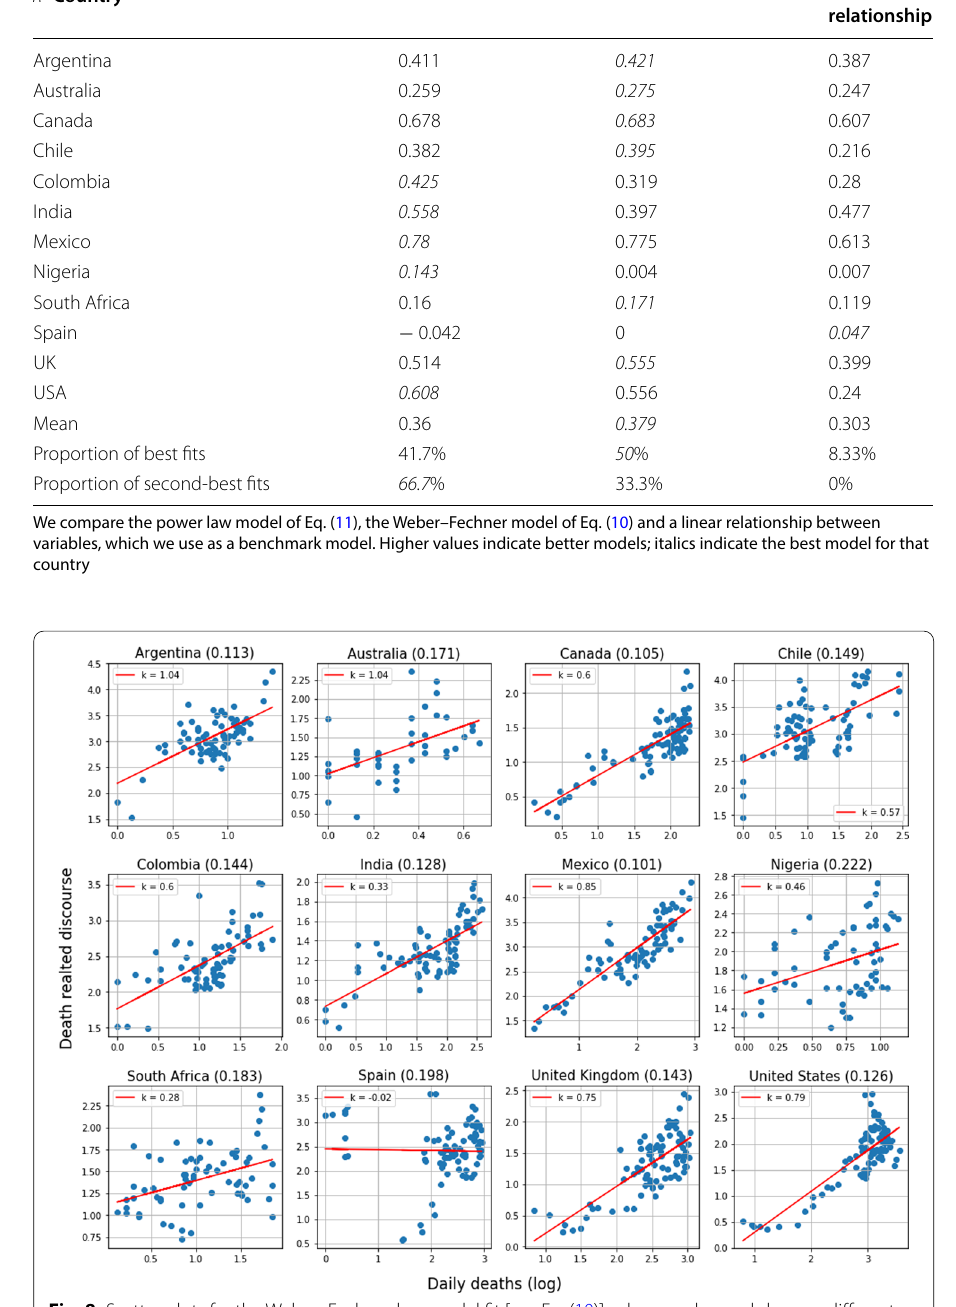
Fig. 8 Scatter plots for the Weber–Fechner law model fit [see Eq. (10)], where each panel shows a different country with their corresponding NRMSE [see Eq. (12)] in parenthesis (the lower the